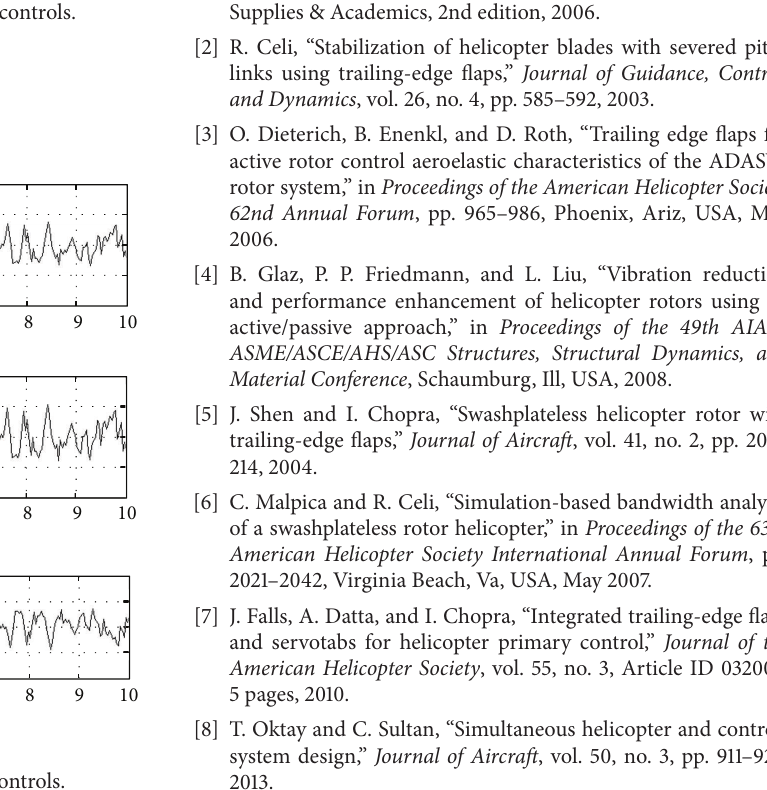
Figure 8: Responses of helicopter MHT